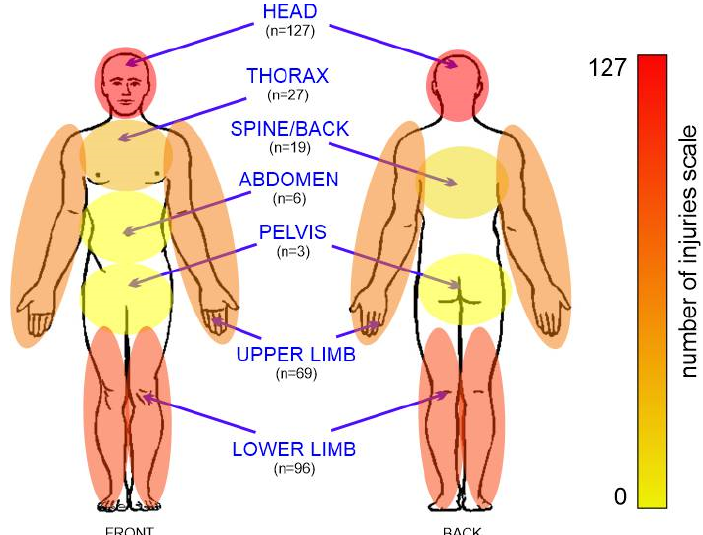
Figure 2. Body injuries of users of single-track vehicles.